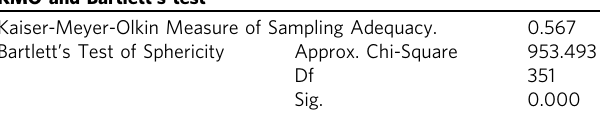
Table 5 The KMO and Bartlett ’ s test of sphericity of process QA for teaching and learning